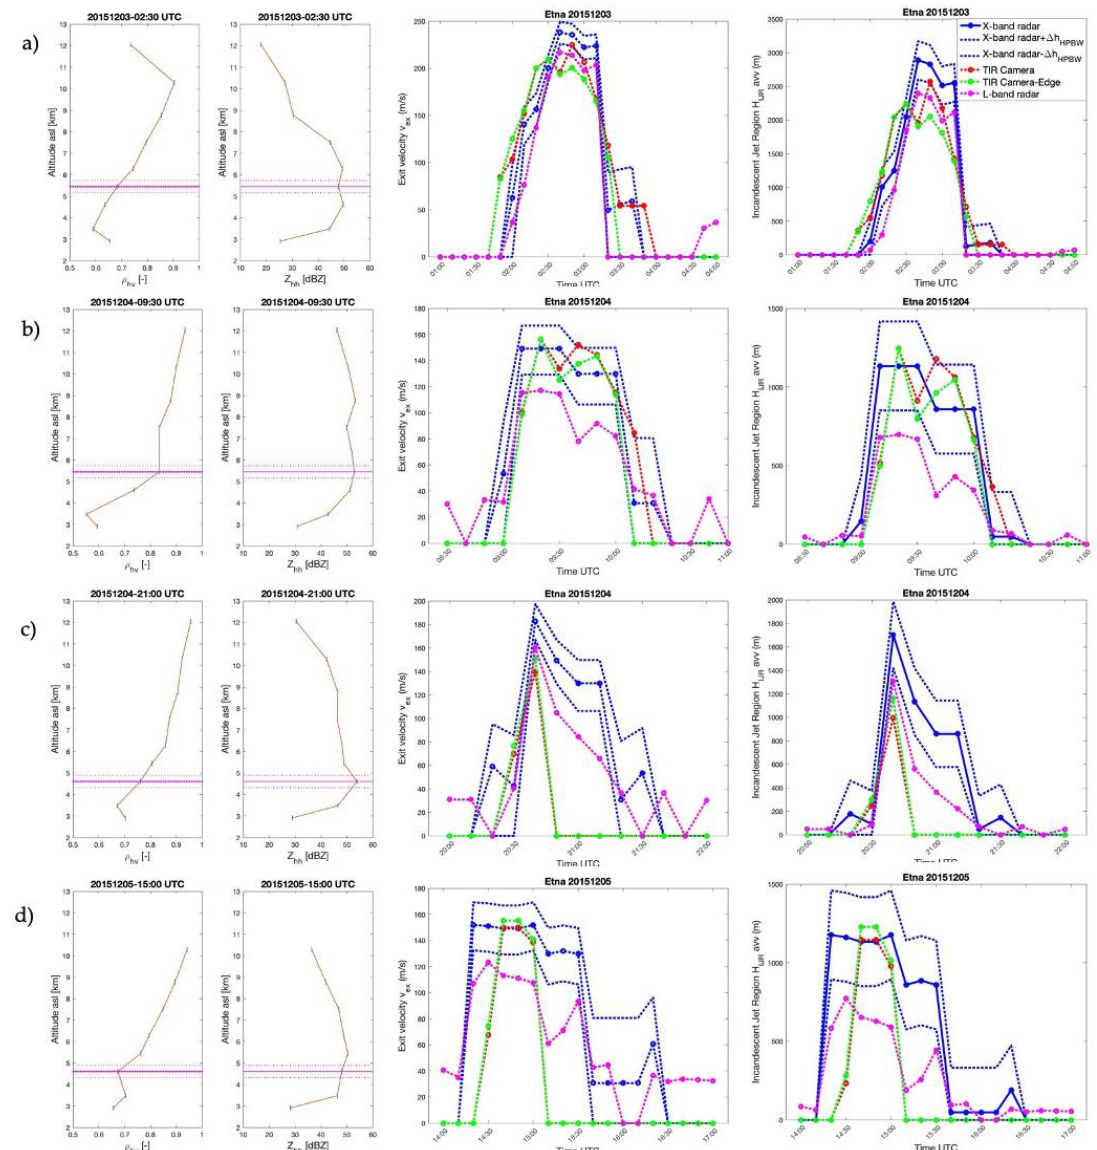
Figure 8. Horizontally averaged vertical profile at the specific time of the copolar correlation coe ffi cient ρ hv (adim) and the reflectivity factor Z hh (dBZ) during the explosive activity on 3 December 2015 at 02:30 UTC ( a ), 4 December 2015 at 09:30 UTC ( b ) and at 21:00 UTC ( c ) and 5 December 2015 at 15:00 UTC ( d ), respectively. The brown line identifies the mean value, whereas the small horizontal blue bars identify the standard deviations computed at each altitude related to radar elevation angles above the crater. Two dashed magenta lines identify the altitude variability range where the algorithm searches at the specified time to maximize Z hh and minimize ρ hv . In the middle and on the right panels, we show the time-series having a time step of 10 min of v ex and H IJR respectively. The H IJR is directly extracted from two TIR camera approaches, TIR Camera and TIR Camera-Edge as in (2) and (3) respectively, and the L-band and X-band radar, latter expressed as in function of the uncertainty ∆ h HPBW (about 300 m) related to half-power beam width of X-band